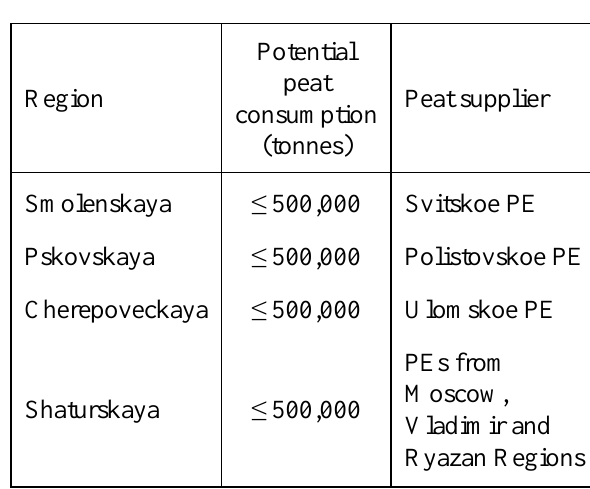
Table 8. Existing regional power plants that are suitable for fuelling with peat. PE = peat